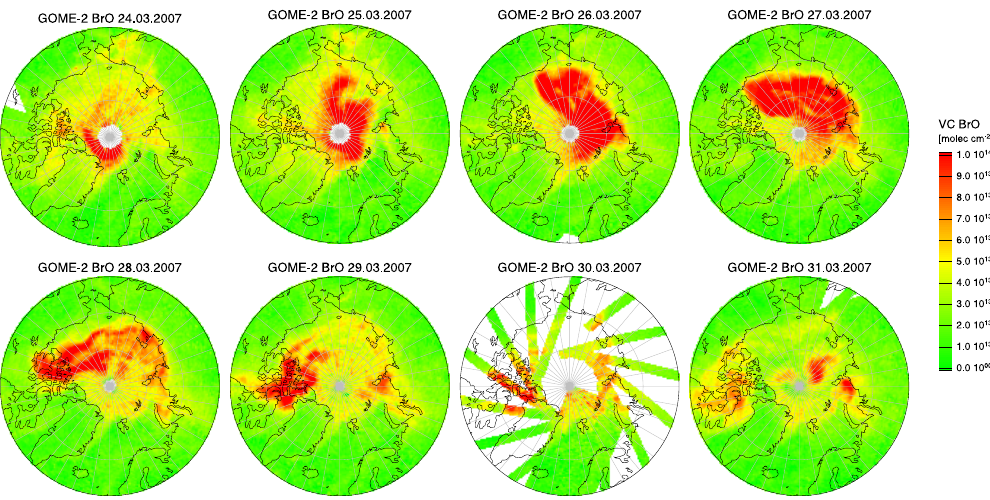
Fig. 1. Daily averaged vertical column of GOME-2 tropospheric BrO measurements corrected by stratospheric climatology data. For the radiative transfer calculations, BrO was assumed to reside in the lowest 400m. Enhanced values on 25 March in East Siberian Sea result from the last orbit of that day at 22:44UTC. The following orbit on 26 March at 00:26UTC (Fig. 3) was used as one input for the FLEXPART model run. On 30 March GOME-2 was operated in narrow swath mode.